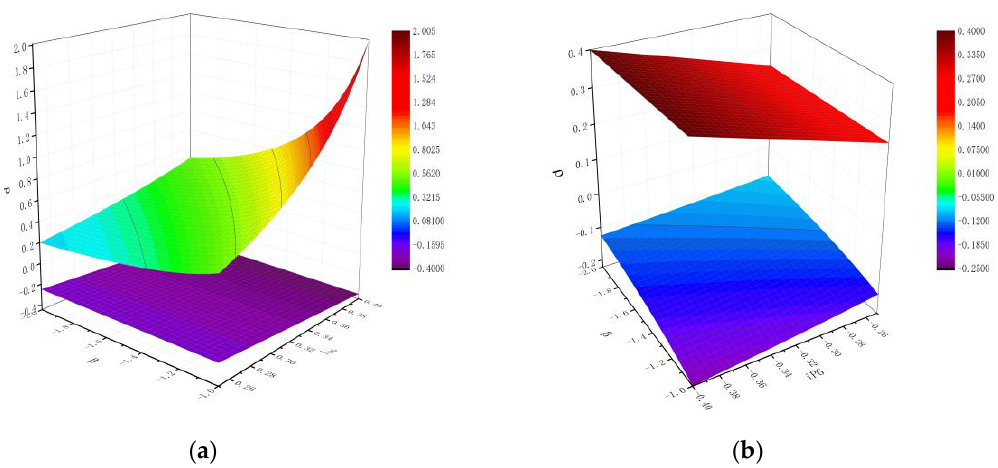
Figure 13. ρ of the matching pattern a. ( a ) ρ M , and ρ m of scheme 1; ( b ) ρ M , and ρ m of scheme 3. Figure 13. 𝜌 of the matching pattern a. ( a ) 𝜌 𝑀 , and 𝜌 𝑚 of scheme 1; ( b ) 𝜌 𝑀 , and 𝜌 𝑚 of scheme 3.